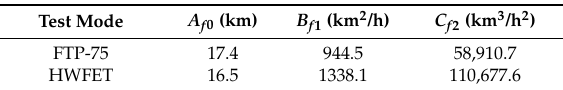
Table 3. Constant of road load coefficients.